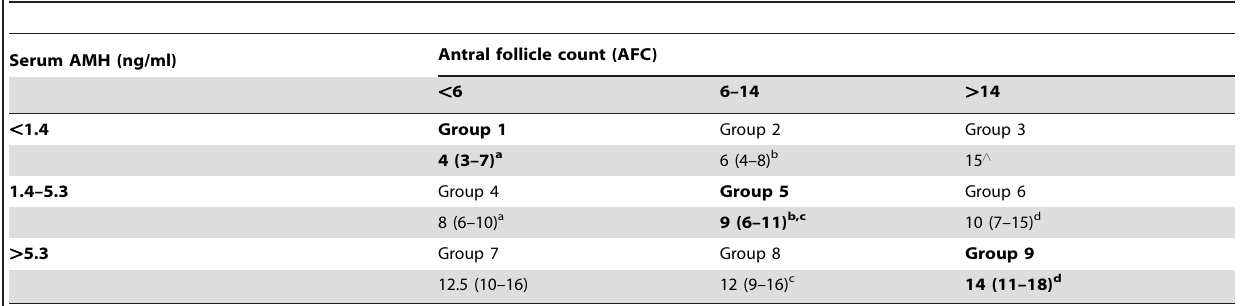
Table 2. Number of retrieved oocytes in different subject groups classified according to the quartile of serum AMH and AFC.